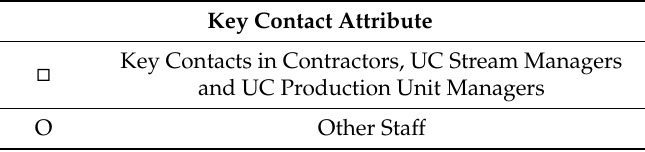
Table 2. Status of the individual in Figure